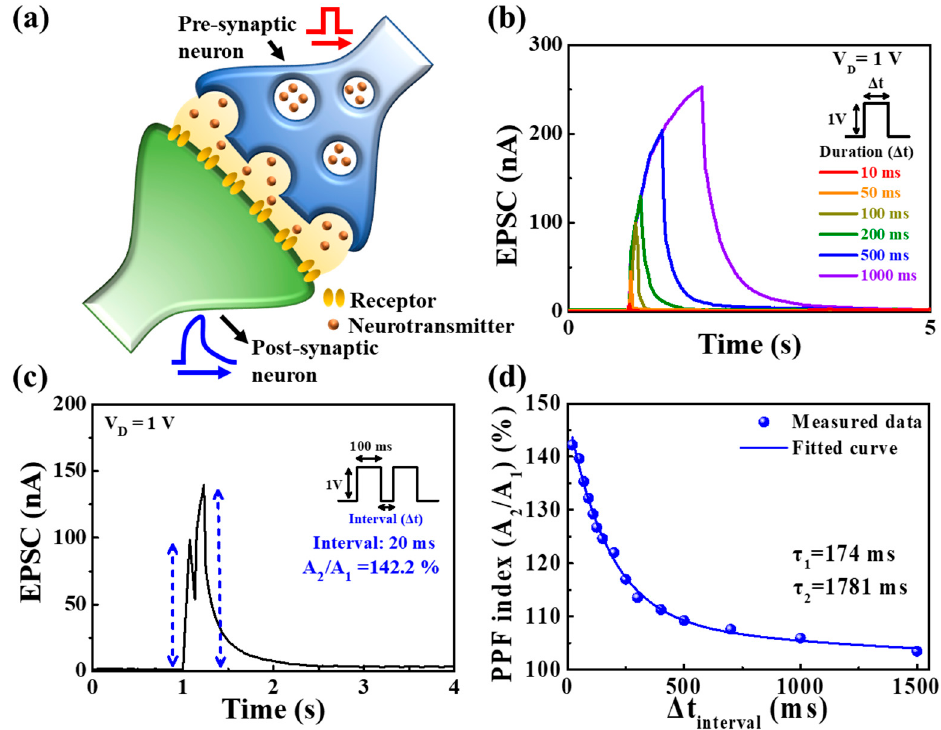
Figure 4. ( a ) Schematic structure representing biological synapses in the actual brain. ( b ) EPSC responses to pre-synaptic single spike pulses with amplitude of 1 V at different durations (10, 50, 100, 200, 500, and 1000 ms). ( c ) EPSCs triggered by paired pre-synaptic spikes (1 V, 100 ms) at time interval ( Δ t interval ) = 20 ms. ( d ) PPF index (A 2 /A 1 ) for different Δ t interval at a spike time of 20–1500 ms.